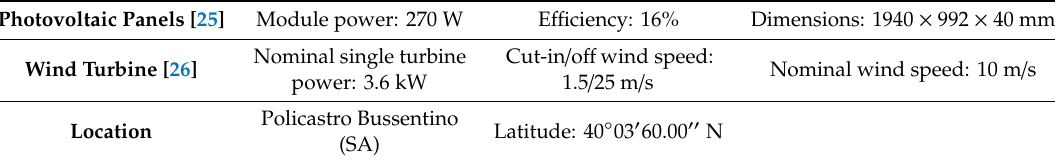
Table 1. PV, WT, and location specs /